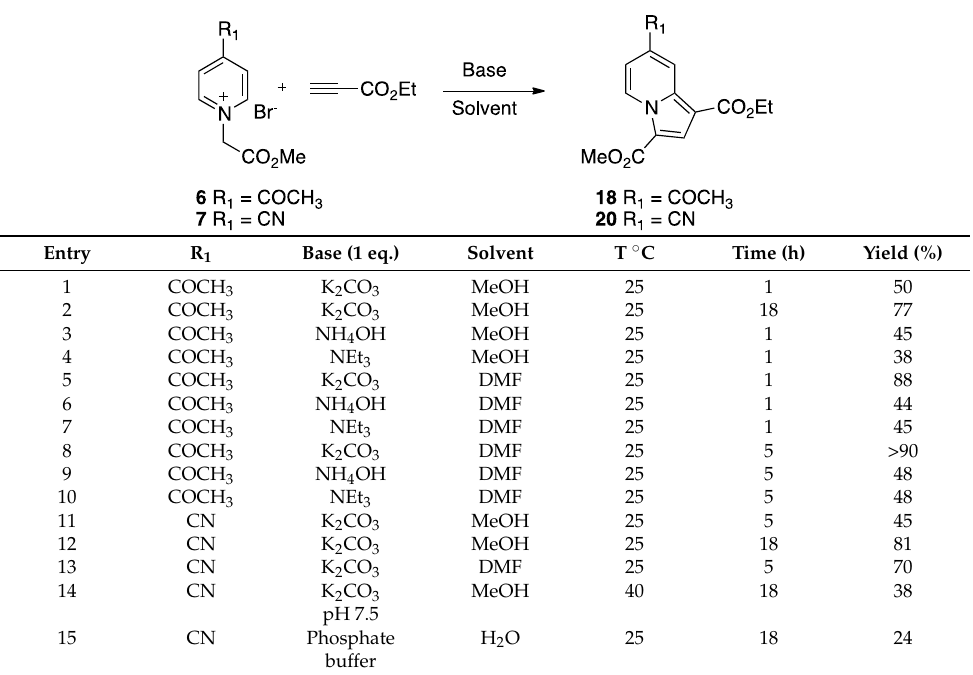
Table 3. Influence of the nature of the solvent and of the base on the yields of indolizines 18 and 20 from pyridinium salts 6 and 7 .